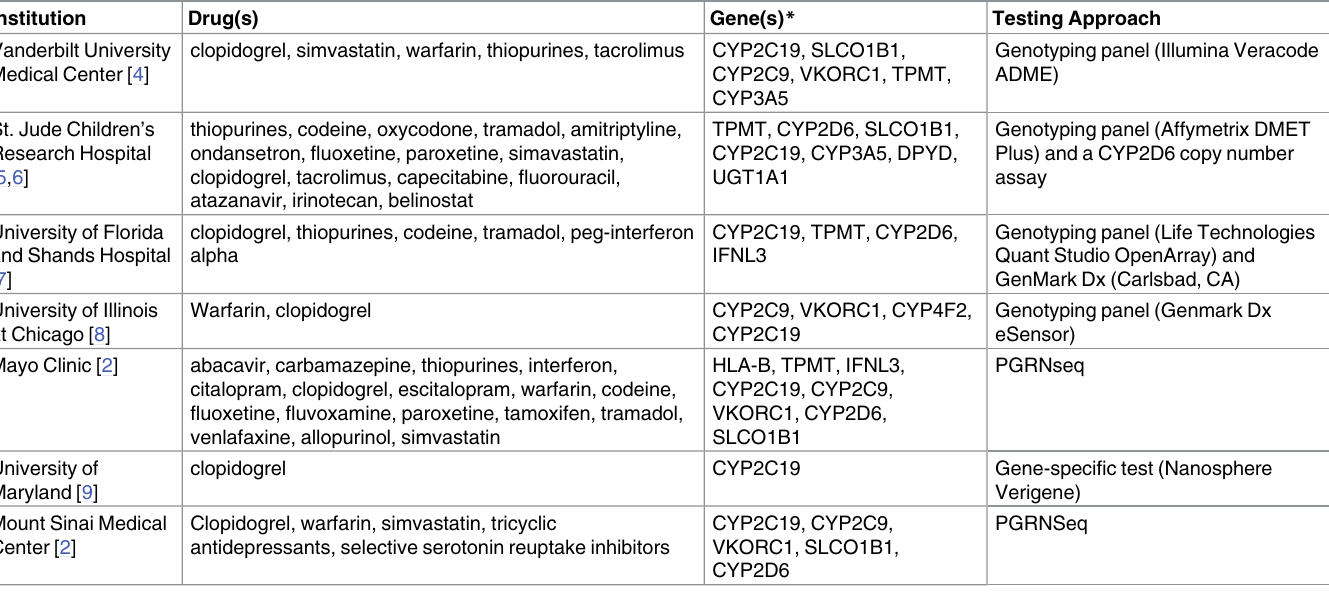
Table 1. Examples of health systemsthat have launched pharmacogenomics